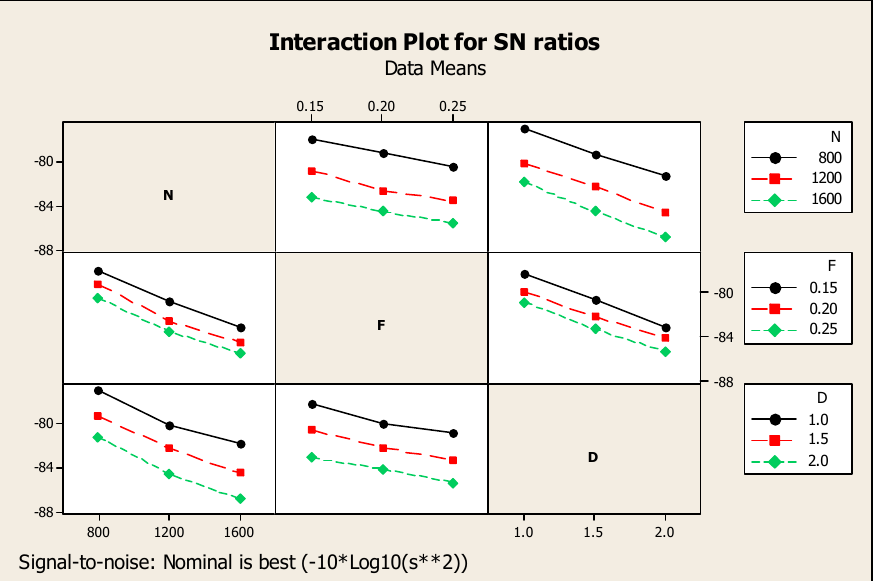
Figure 14. MRR, SR, and CF-related interaction diagram.